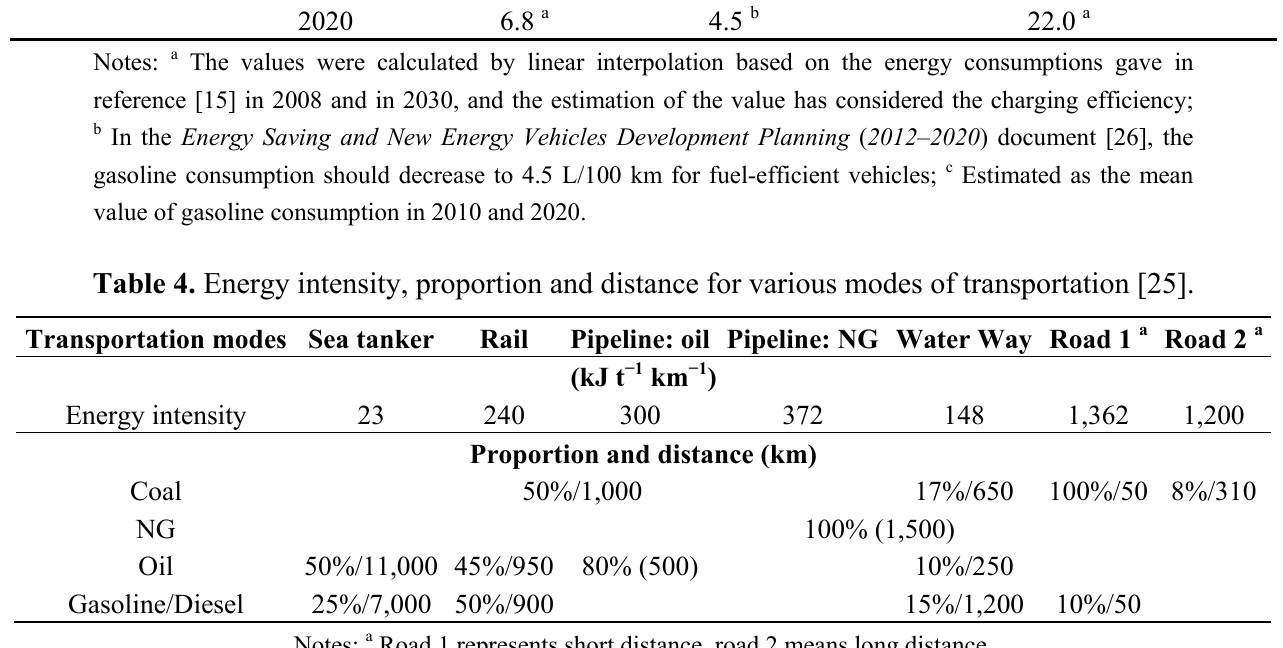
Table 5. The energy consumption during the fuels’ production and transportation stage. Energies